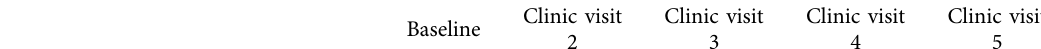
Table 3: Example fowchart to assist in managing T2DM.